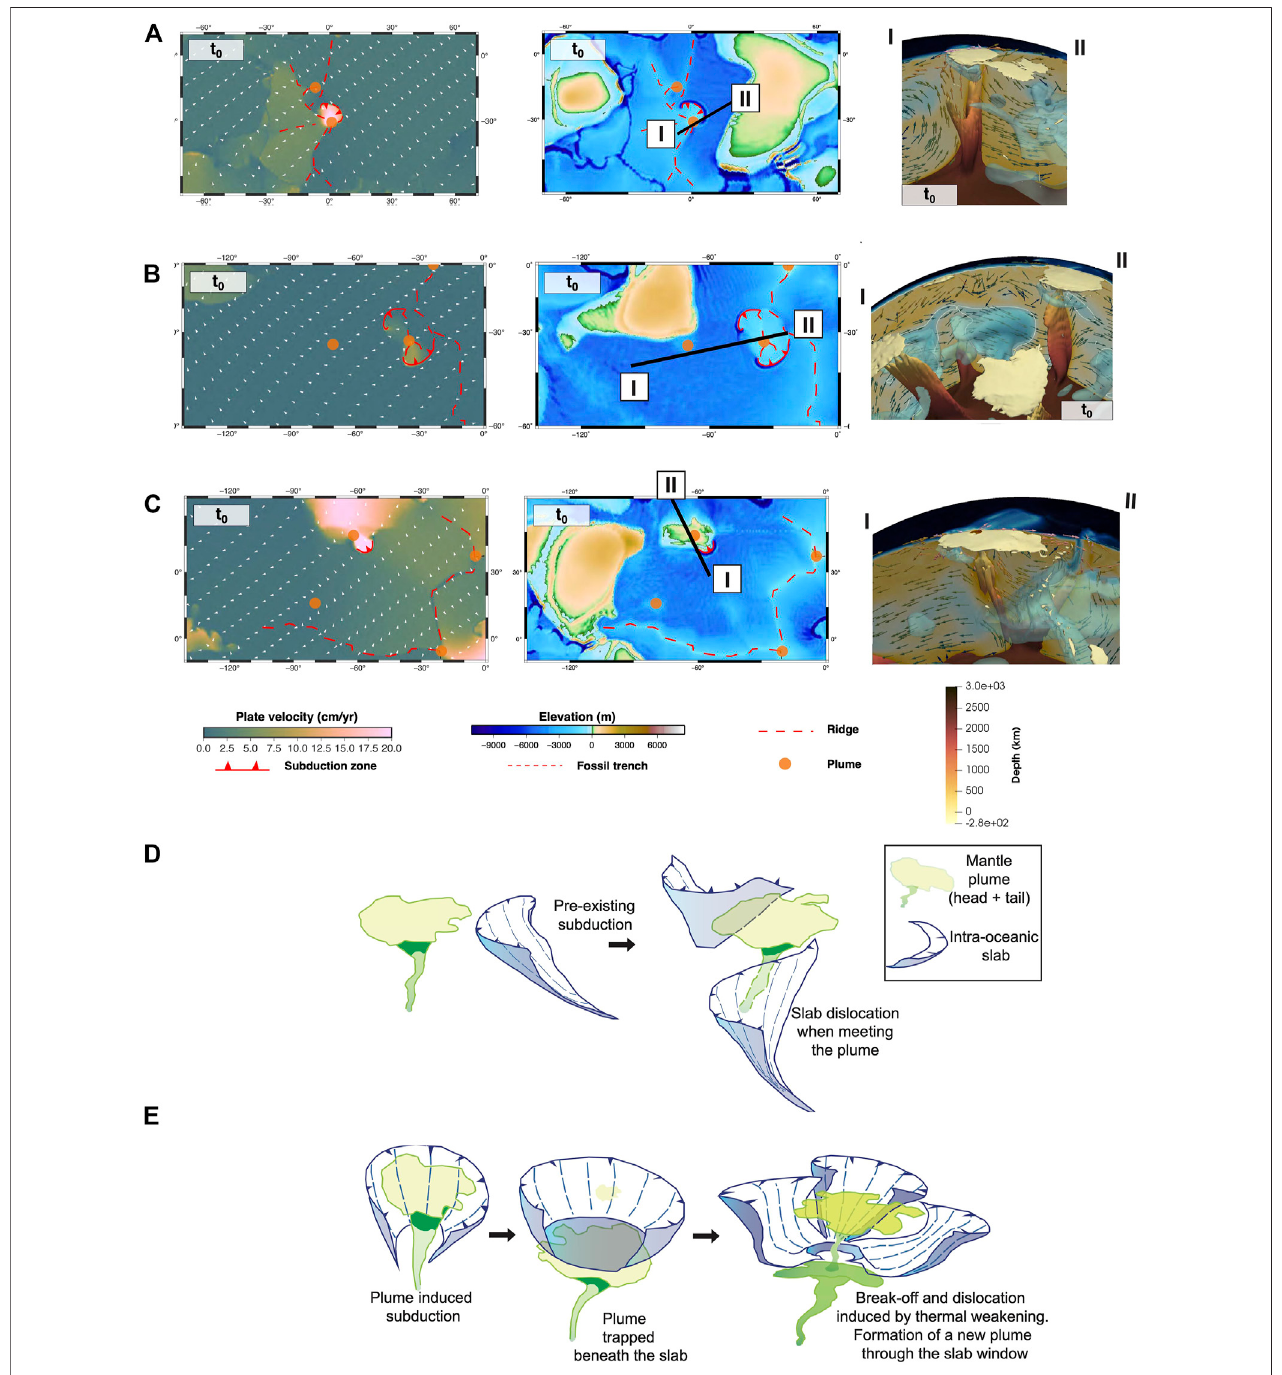
FIGURE 10 | Model results of Rodriguez et al. (2021). (A – C) Three facilitating conditions for plume-induced subduction initiation obtained from 3D mantle convection models: (A) interaction of a plume head with young oceanic lithosphere close to an asymmetric spreading ridge results in initiation of semi-circular subduction, (B) impingement of a plume head on young and thin lithosphere near a ridge initiates two-lobe-shaped subduction, (C) a one-sided arcuate trench initiates near a plume head located away from a plate-boundary. In all panels (A – C) , (1) shows surface velocity map, (2) illustrates surface view of plate boundary con fi gurationsand (3) displays3Dcrosssectionsoftheplume-inducedsubductionsystem. (D – E) Schematicillustrationoftwodifferentinteractionsbetweenplumeand subduction: (D) whensubductionhitsaplume,theslabsplitsintoseveralsegments,and (E) plume-inducedsubductioncanhindertheplumefromrisingforafewmillion years which is followed by division of the subducted slab into several segments in order to allow resumption of plume upwelling. Figures are modi fi ed from Rodriguez et al. (2021).